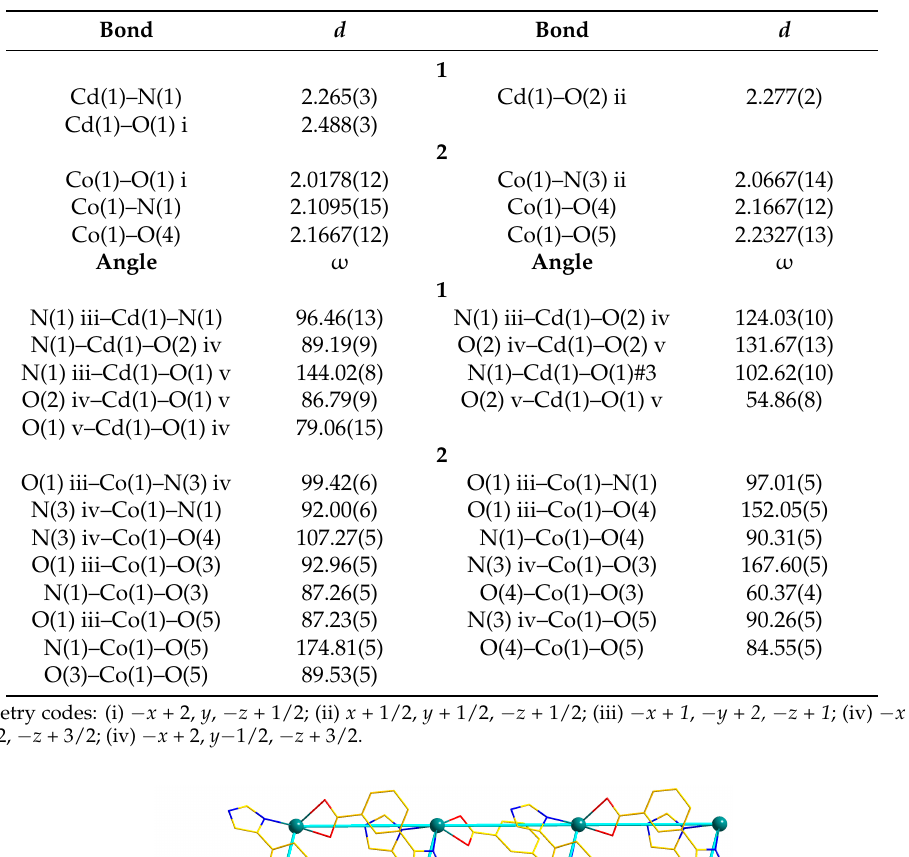
Table 1. Selected bond lengths (Å) and bond angles ( ◦ ) for 1 and 2 .